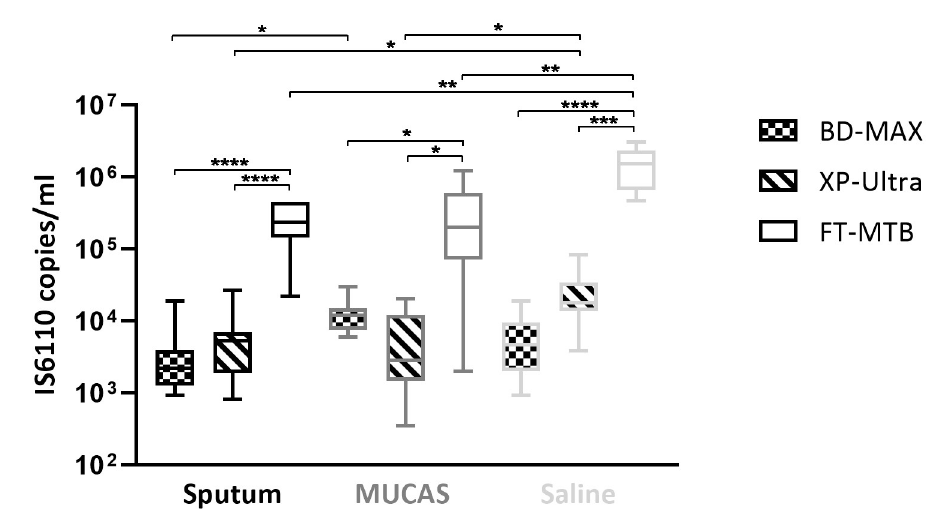
Fig 3. Whiskers Min to Max of IS 6110 copies at the limit of detection of BD-MAX, XP Ultra and FluoroType in different test matrices. Assays were performed in human sputum (Sputum), artificial sputum (MUCAS) and 0.85% saline solution (Saline). The limit of detection (LoD) was determined using two-fold dilutions of H37Rv spiked in test matrix. Number of test series of BD-MAX, XP-Ultra, FT-MTB in human sputum, MUCAS and saline were 8, 10, 6, and 8, 9, 9 and 9, 6, 9, respectively. ���� p � 0.0001, ��� p � 0.001, �� p � 0.01, � p � 0.05 (one-way ANOVA with Tukey’s multiple comparison test).